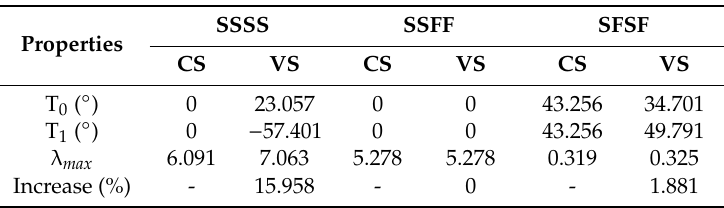
Table 13. Optimal angles of a single layer VS plate for maximum uniaxial load multipliers, with simply supported boundary